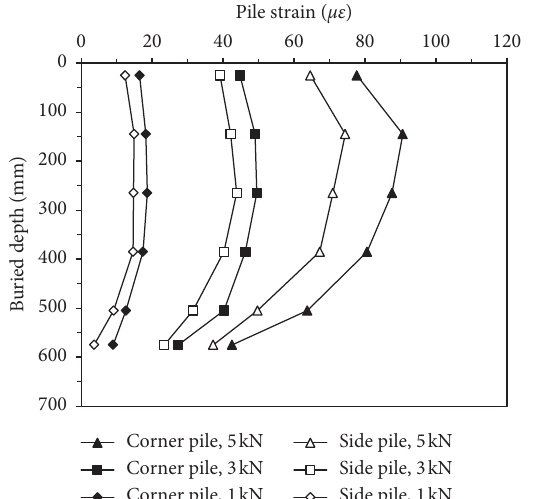
Figure 9: Pile strain-buried depth curves of corner pile and side pile with the number of load cycles of 50,000 under cyclic loading.